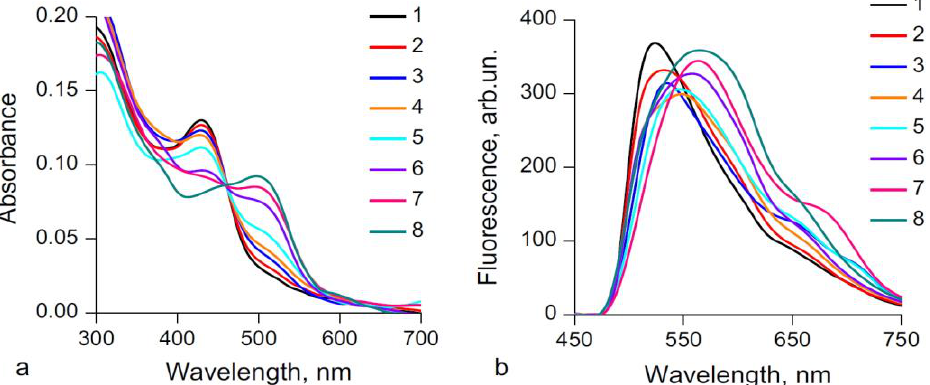
Figure 7. UV–vis absorption ( a ) and fluorescence ( b ) spectra of 30-layer LS film of QC8 ( 1 ) transferred onto quartz (LB) and PVC (LS) substrates, at 20 mN m − 1 and immersed in aqueous solutions with pH 3.00 ( 2 ), lemon juice 2.45 ( 3 ), 2.00 ( 4 ), lime juice 1.95 ( 5 ), 1.5 ( 6 ), kefir whey 1.20 ( 7 ), and 1.0 ( 8 ) for 30 s, λ ex = 420 nm.